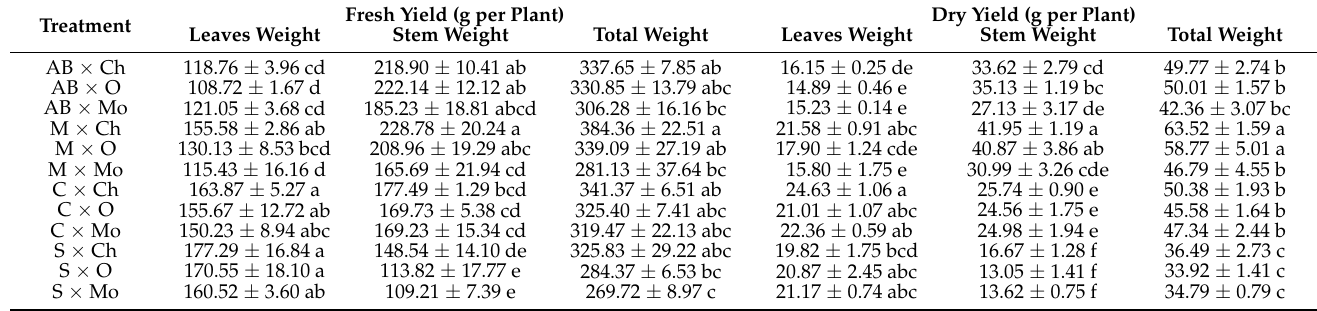
Table 5. Interaction between cultivar and fertilization type on basil yield characteristics.